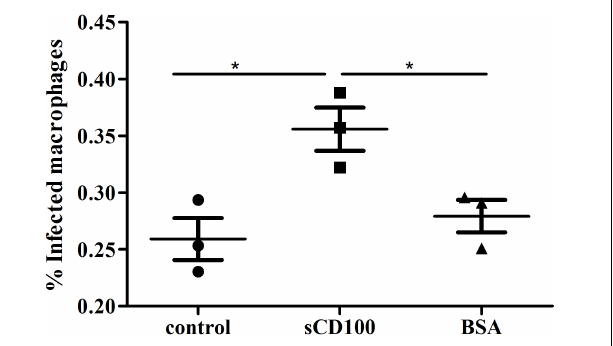
FIGURE 8 | Effects of sCD100 on infection of macrophages by Trypanosoma cruzi. Macrophages from BALB/c mice were infected with T. cruzi trypomastigotes at a MOI of 10 for 24 h in the presence or not of 200 ng/mL sCD100. Statistical analysis was performed by ANOVA with Tukey’s post-test, and significant differences are labeled as ∗ p ≤ 0.05. Results of one experiment representative of two with similar